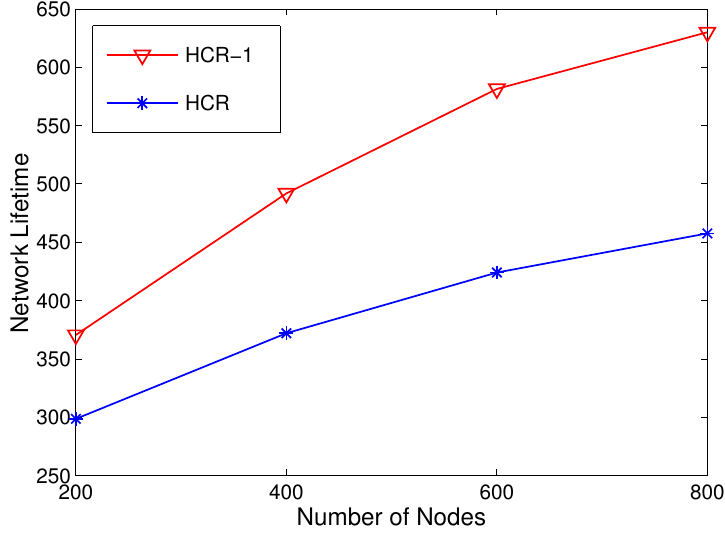
Figure 11. Network lifetime comparison with different node